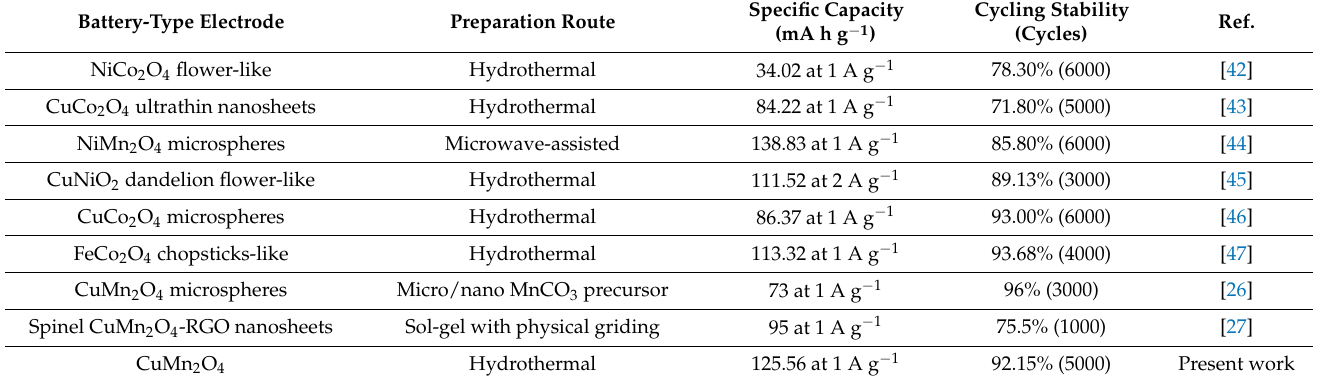
Figure 5. ( a ) Cycling stability (inset depicts the SEM image after the stability test). The CuMn 2 O 4 NSA electrode ( b ) CV, ( c ) GCD, and ( d ) EIS graphs before and after cycle testing. Table 1. The energy storage behavior of the current battery-type CuMn 2 O 4 NSAs electrode and previ- ously disclosed battery-type binary metal oxide electrodes and other reported CuMn 2 O 4 hierarchical structures are